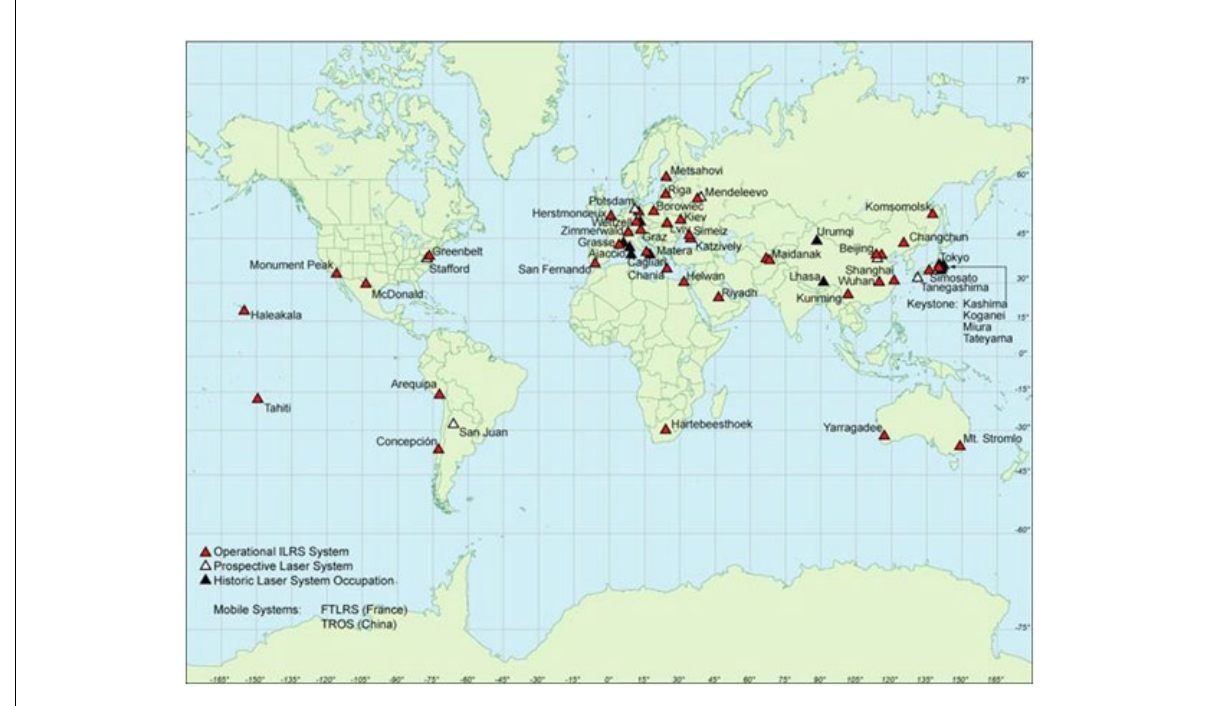
Figure 2: Global distribution of the International Laser Ranging Service (ILRS) tracking